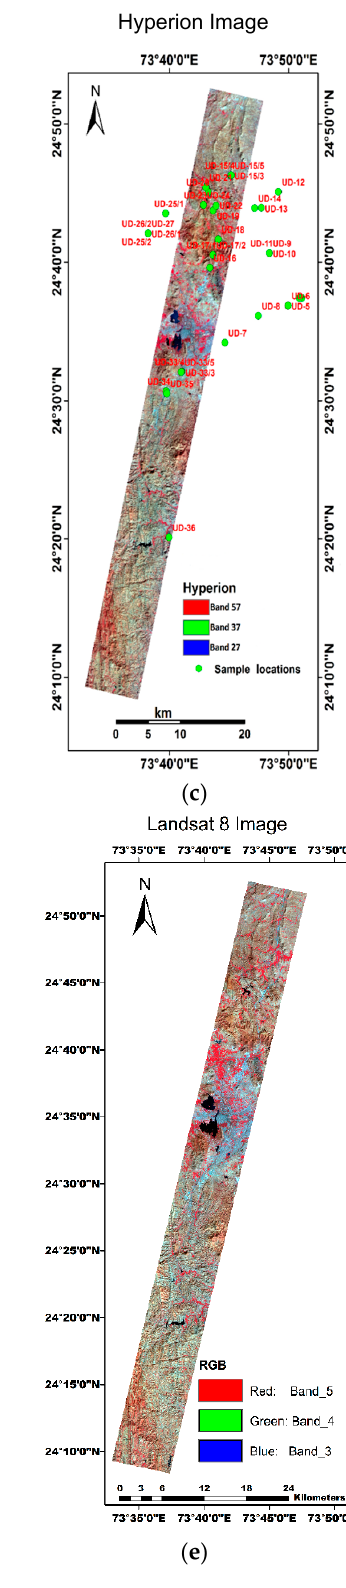
Figure 1. Study area and datasets: ( a ) Location, ( b ) bedrock lithology, ( c ) false color composite (FCC) image of Hyperion image with field sample collection and verification locations, ( d ) FCC image of ASTER, and ( e ) FCC image of Landsat 8.